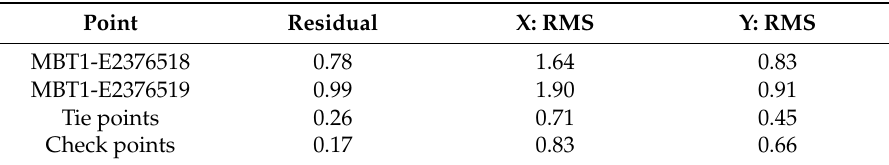
Table 3. Resulting error values in EROS B images.